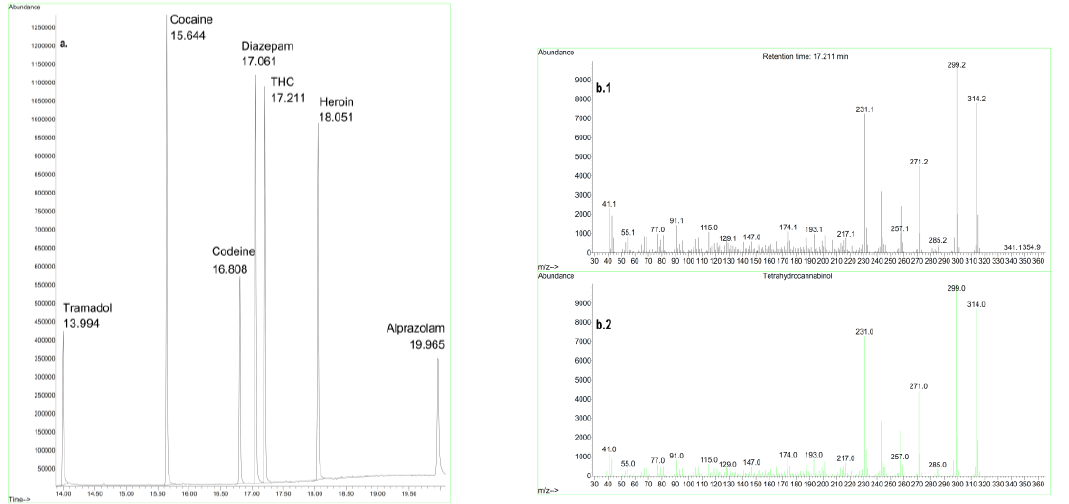
Figure 4. GC-MS chromatogram of multiple drugs of abuse ( a ), in addition to the mass spectrum of THC ( b1 ) (tetrahydrocannabinol, which is the psychoactive ingredient in marijuana) and a spectral library match for THC ( b2 ).